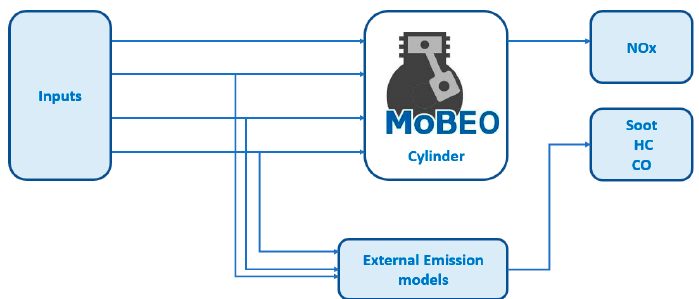
Figure 7. External emission models for CO, THC and Soot.